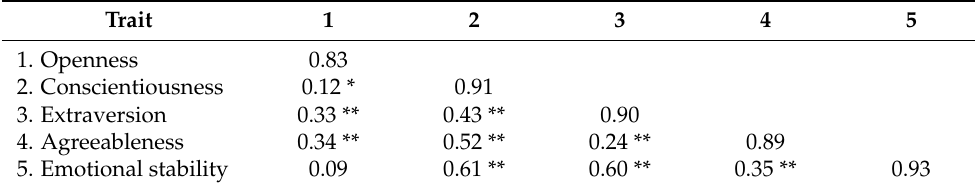
Table 2. A correlation matrix for the questionnaire-based measure (Sample 2; N = 431). Trait